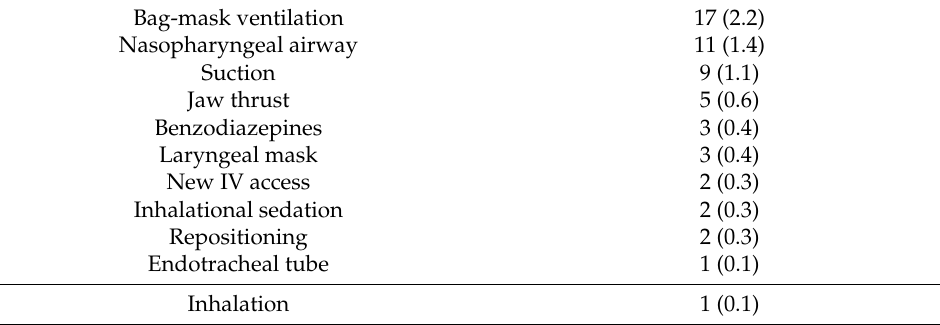
Table 4. Interventions during sedation.